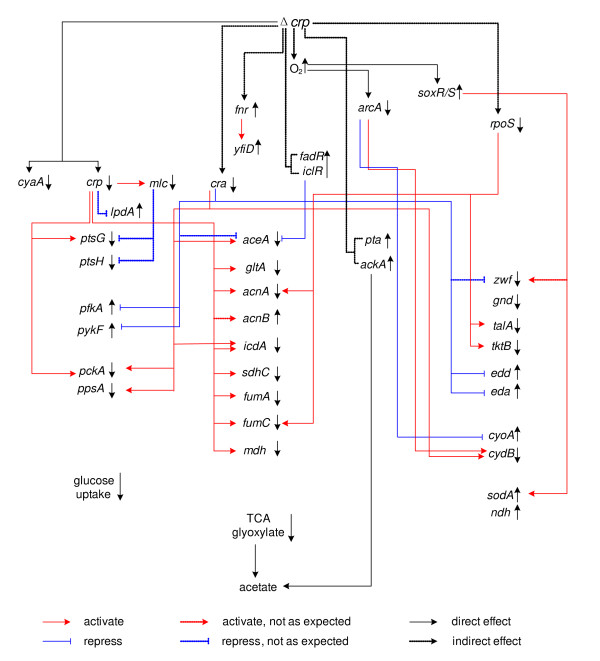
The overall regulation of Δcrp mutant.